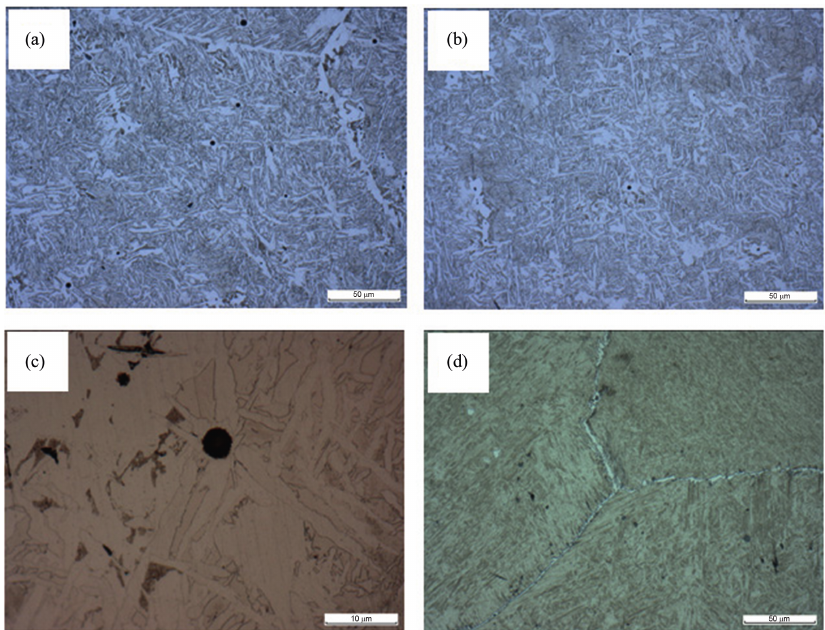
Figure 3: (a) – (c) The sample ’ s optical microstructure; (d) The optical microstructure of comparison sample